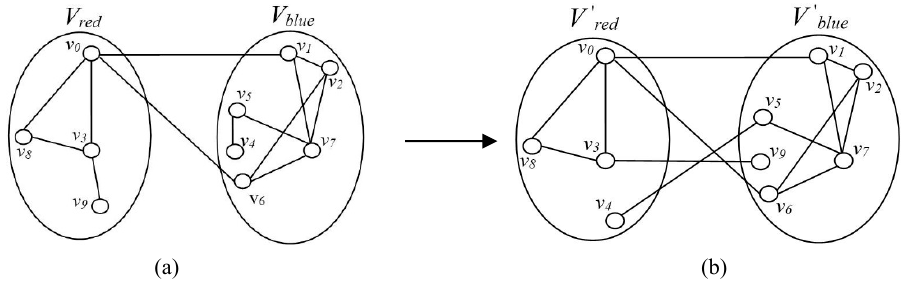
Figure 4. Bipartition scheme splitting: ( a ) bipartition scheme before the splitting; and ( b ) bipartition scheme after the splitting.